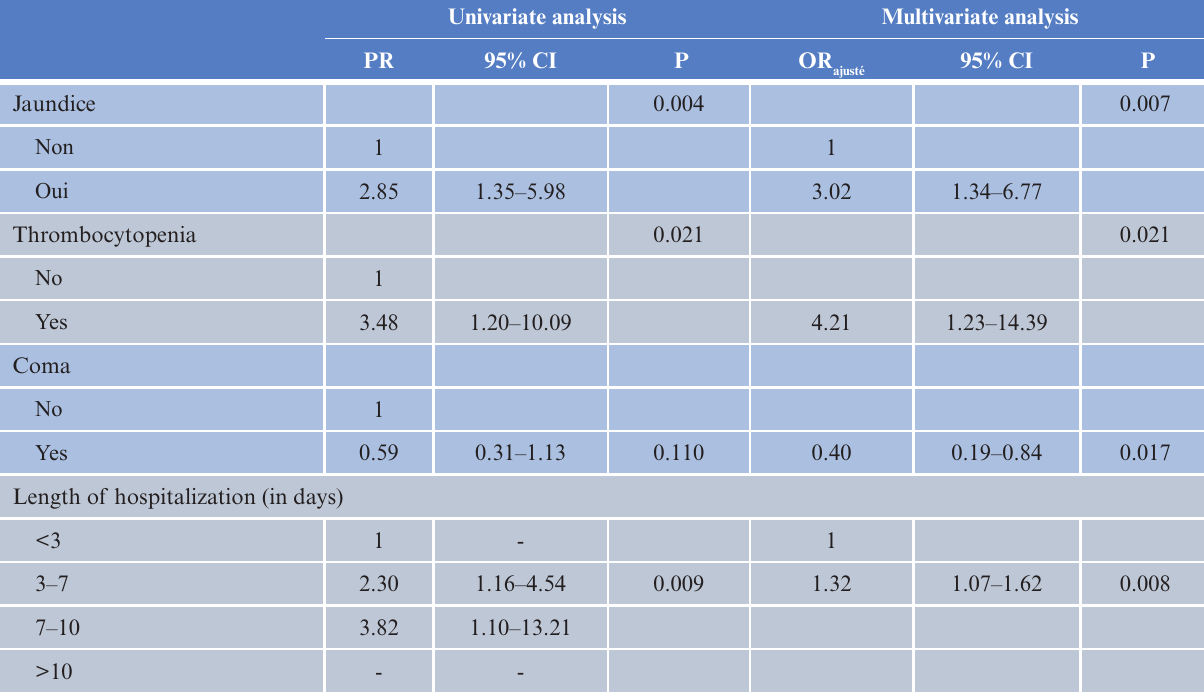
Table 5: Predictors of the occurrence of renal impairment in severe malaria in children at Borgou DTH in 2021 after univariate and multivariate